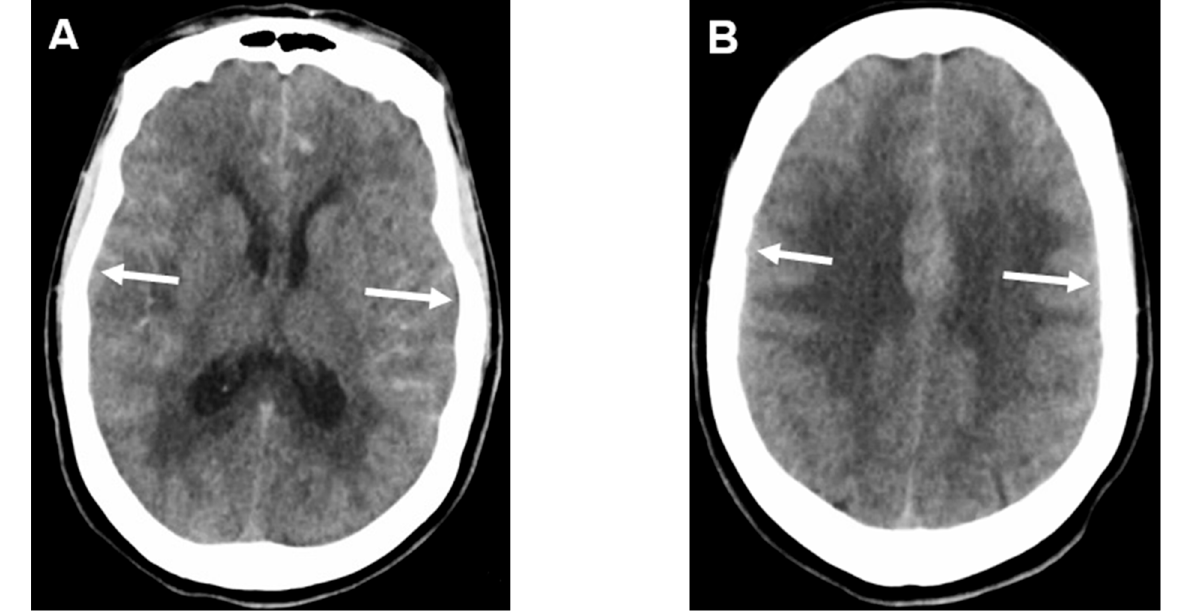
Figure 3. SEBES score calculation from non ‐ contrast CT of the head. ( A ) Slice 1 with 2 points for bilateral effacement of sulci. ( B ) Slice 2 of the same CT with 2 points for bilateral sulcal effacement. The total SEBES score for this scan is 4.